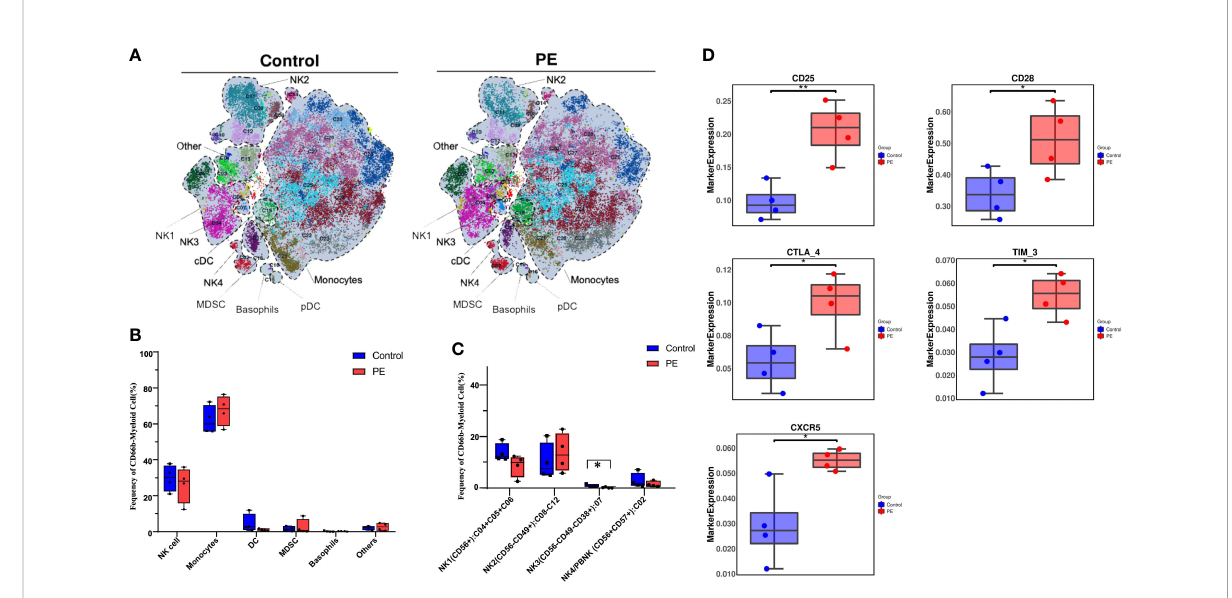
FIGURE 4 A novel CD56-CD49a-CD38+ NK cell subset was found to be decreased signi fi cantly in PE by reclustering CD45+CD3-CD19-CD66b- myeloid cells. (A) The main subsets of the CD45+CD3-CD19-CD66b- myeloid cells were merged as a t-SNE plot of 21 clusters of CD3+ T cells from the PE and control groups and merged as monocytes, natural killer (NK) cells, dendritic cells (DCs), myeloid-derived suppressor cells (MDSCs), basophils, and others, among which NK cells were further divided into four subsets. (B) Bar plot of the frequencies of the merged subsets shown in panel (A, C) The frequencies of the four NK cell subsets are shown in the bar plot. (D) The markers expressed were signi fi cantly different in NK cells of the PE and control groups. The blue bar and red bar in panels B and C denote the control and PE groups, respectively. * stands for p-value <0.01. ** stands for p-value